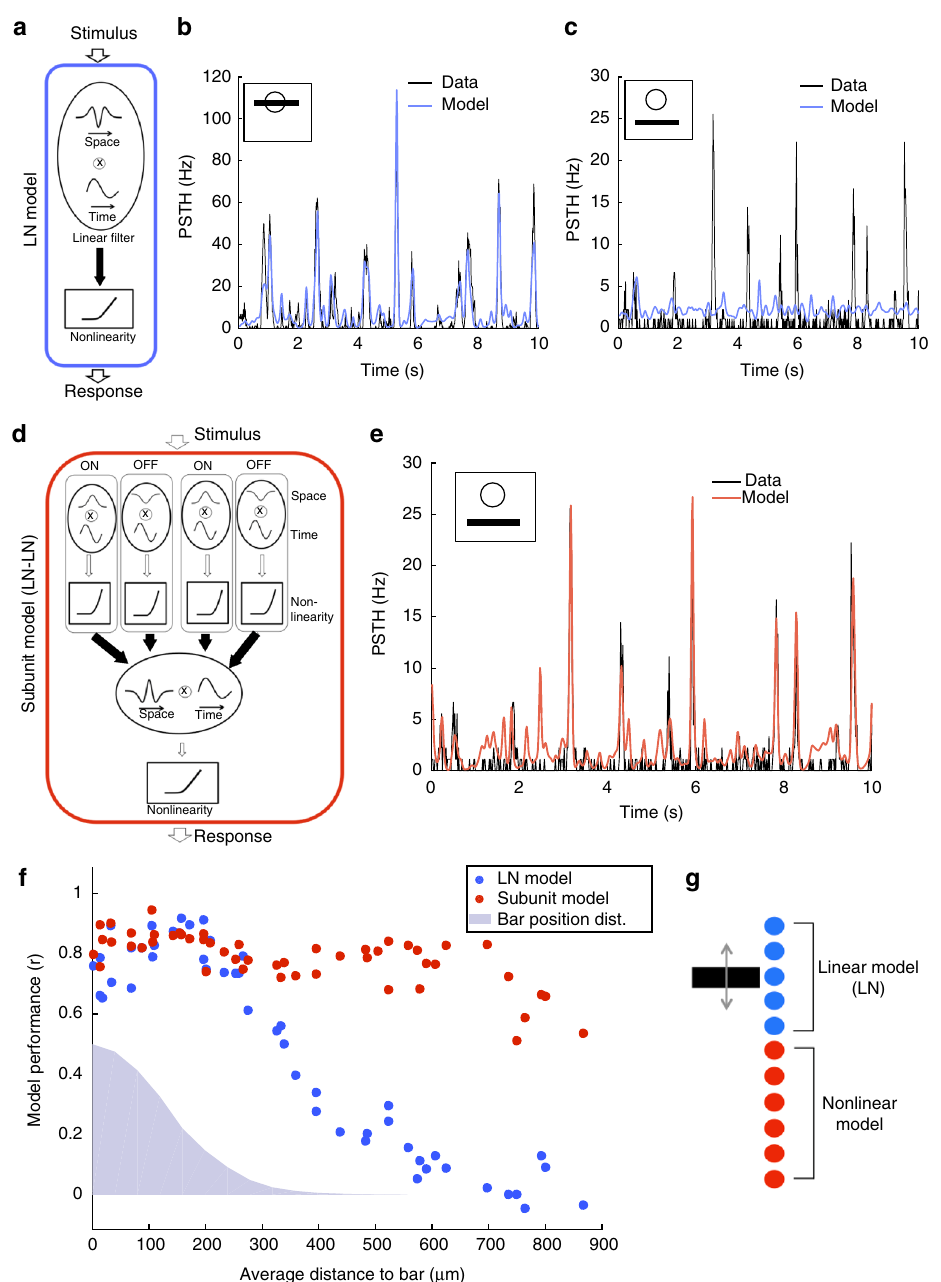
Fig. 2 OFF ganglion cells perform a quasilinear computation in their receptive fi eld center, and a nonlinear computation in the surround. a Schematic of the LN model, composed of a linear fi lter and static nonlinearity. b Response (PSTH, black) of a ganglion cell whose receptive fi eld center is stimulated by the bar, is predicted by the LN model (blue). r = 0.89. c Response (PSTH, black) of the same ganglion cell when the bar is far from the receptive fi eld center, is not predicted well by the LN model (blue). r = 0.02. d Schematic of the subunit model, composed of a fi rst stage (each subunit linearly fi lters the stimulus and applies a static nonlinearity), followed by weighted linear pooling and a second nonlinearity. Filled arrows correspond to learned weights of the model. e Response (PSTH, black) of the same ganglion cell (as in b , c ) to distant stimulation is predicted well by the subunit model (red). r = 0.83. f Performance of the LN (blue) and subunit (red) models in predicting ganglion cell responses, as a function of the distance of the cell to the bar. Blue shade: position distribution of the bar. g Schematic showing that cells whose receptive fi eld center is on top of the moving bar perform a quasilinear computation while distant cells perform a nonlinear